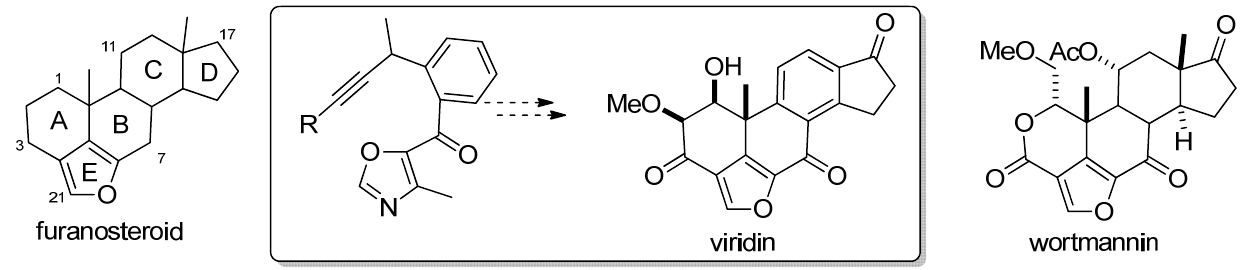
Figure 5. Furanosteroid class of PI3-kinase inhibitors